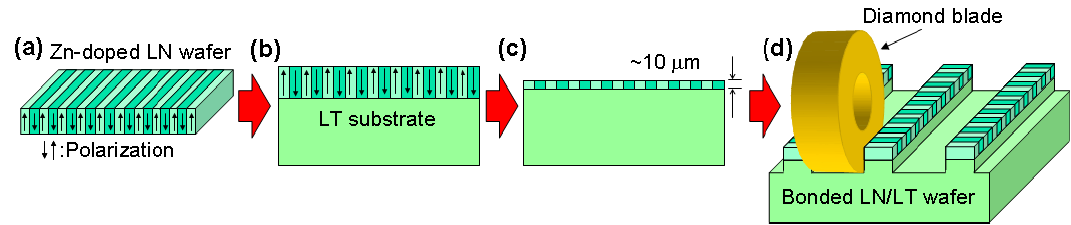
Figure 2. Process for fabricating direct-bonded ridge waveguide: ( a ) electrical poling; ( b ) direct bonding; ( c ) lapping and polishing; ( d ) waveguide fabrication using dicing saw.